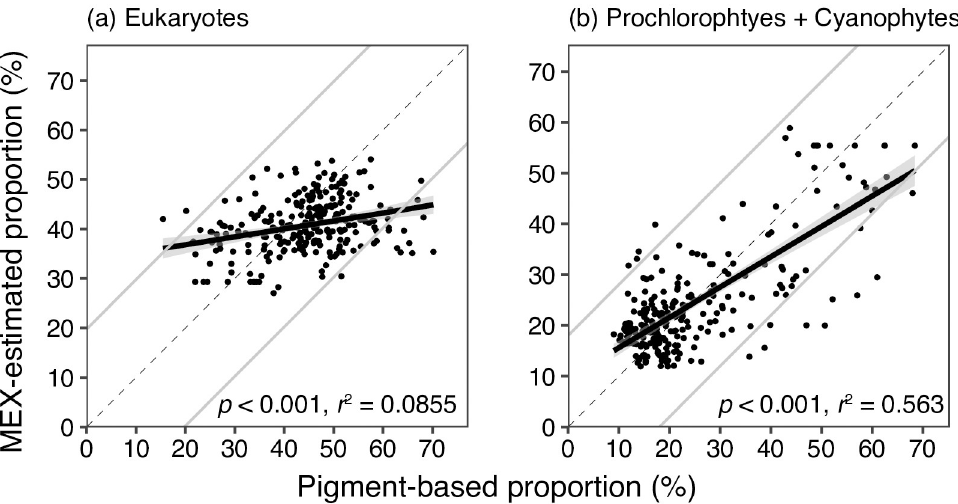
Fig 5. Same scatter plots with Fig 4 but performed in (a) eukaryotes and (b) sum of cyanophytes and prochlorophytes to TChla (total chlorophyll a ) concentration. The MEX-based proportion was estimated based on the database ( U 2), which removed the data collected in the same area from U . The dashed and the bold lines with shadow denote the 1:1 line and the linear regression line with standard errors regression analysis, respectively. The gray lines indicated 95% confident intervals of the differences between MEX-based and plant pigment-based proportions.